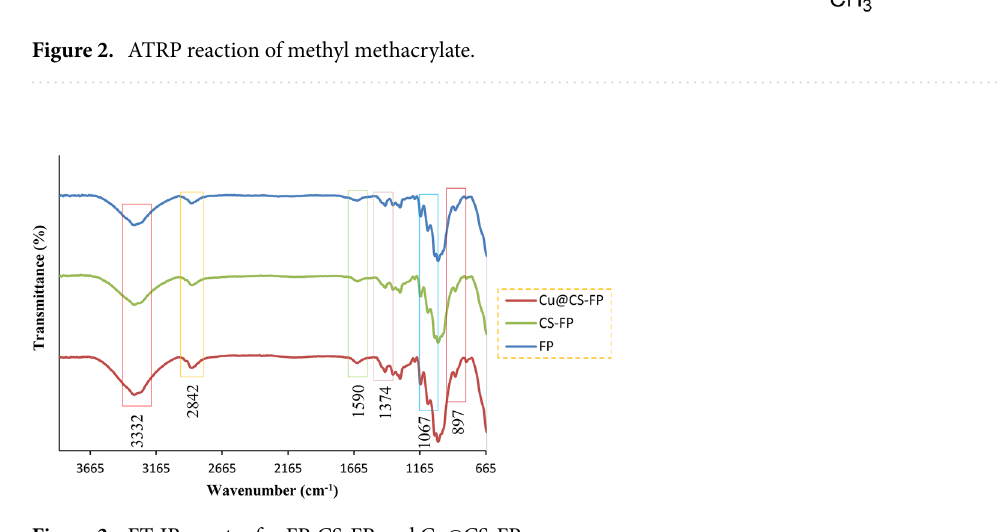
Figure 3. FT-IR spectra for FP, CS-FP, and